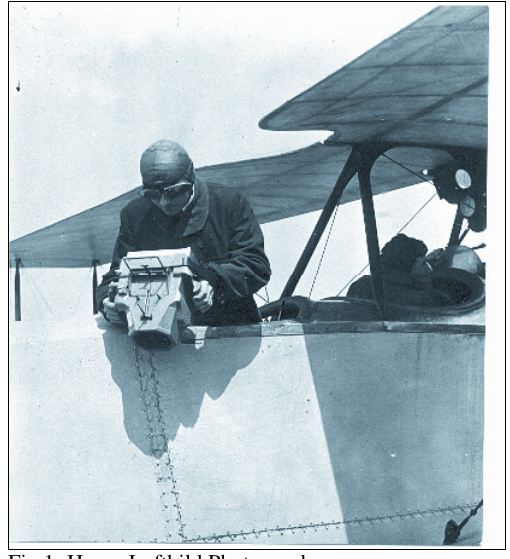
Fig 1: Hansa Luftbild Photograph Fig 2: Bundermann Chain (Antarktis) Max